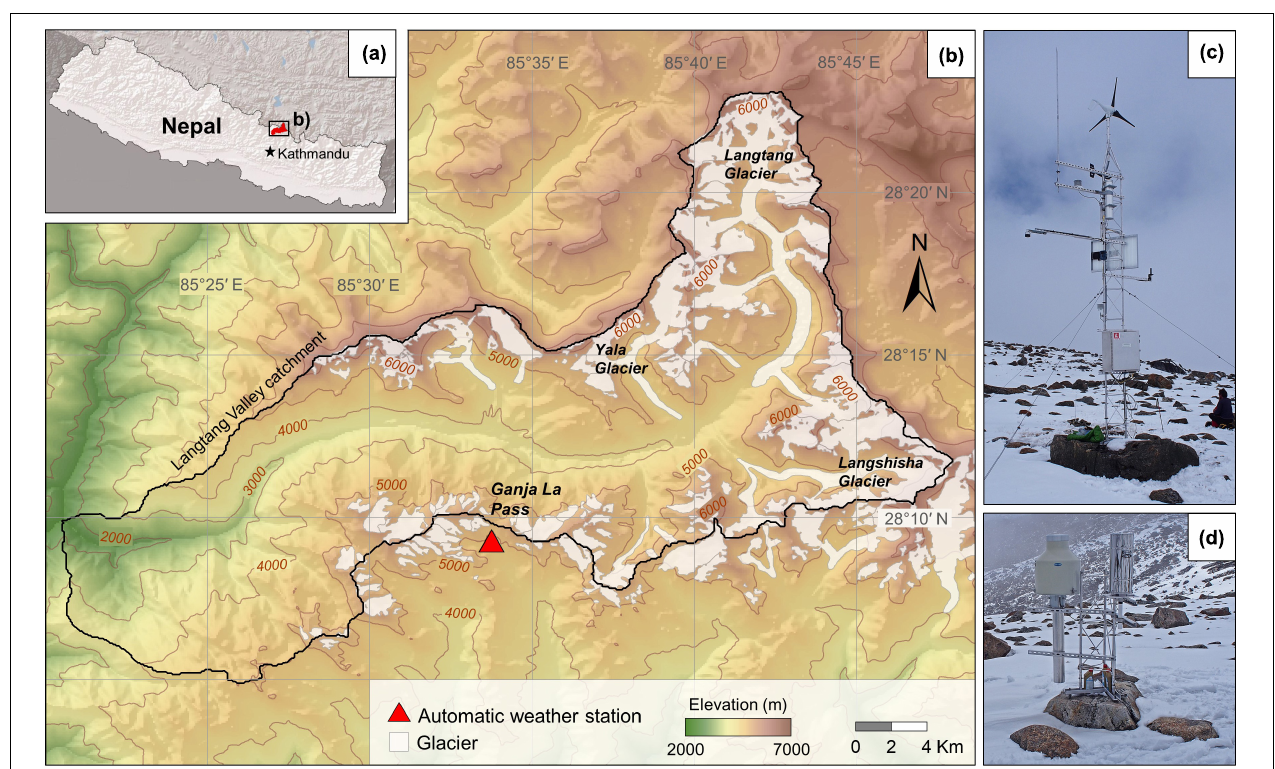
FIGURE 1 | Study site and instruments. (a) Location of the Langtang catchment, adjacent to the study site, Nepal. (b) The automatic weather station is located on the southern side of the Ganja La Pass at 4962 m.a.s.l. Major glaciers and ice masses in Nepal are displayed (Bajracharya et al., 2014). (c) The automatic weather station and (d) the Total Precipitation Gauge at the Ganja La Pass in May